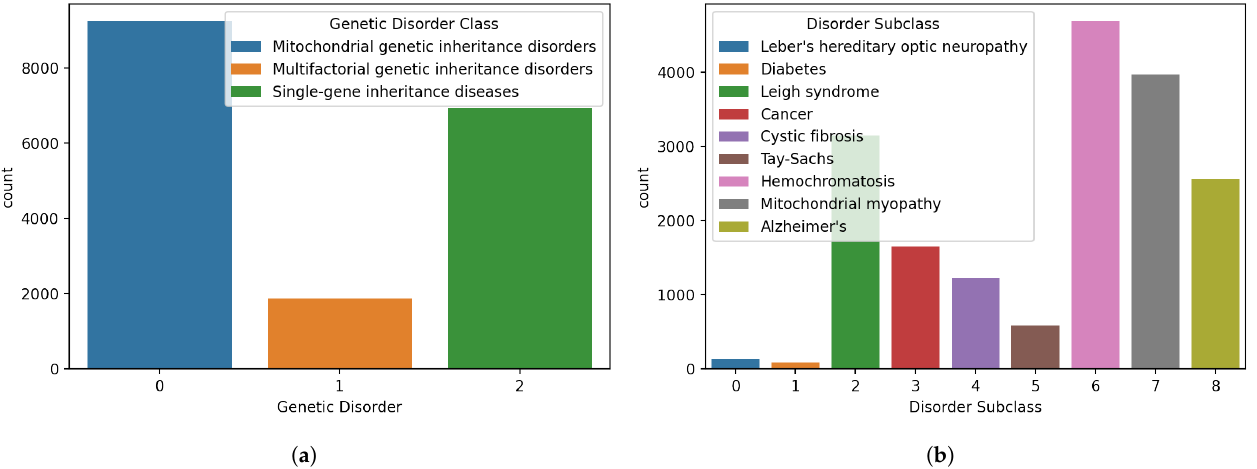
Figure 2. Distributions of samples for different classes in the dataset, ( a ) genetic disorders’ main classes, and ( b ) genetic disorder